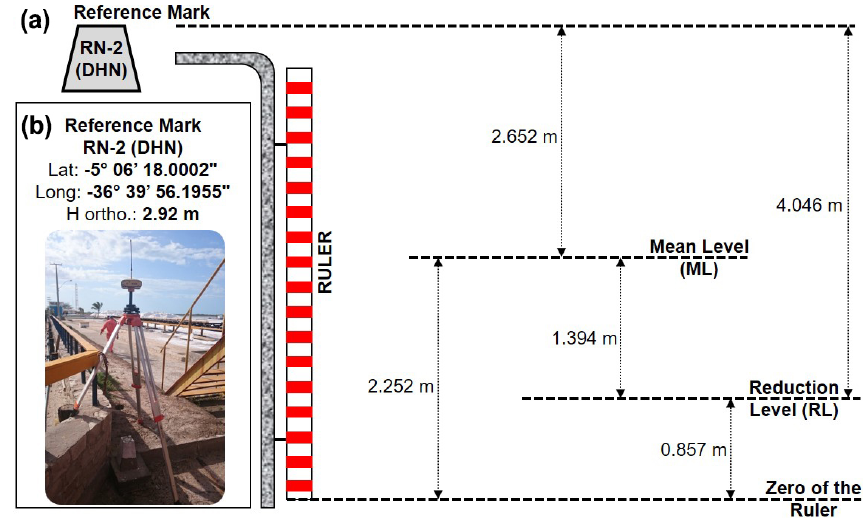
Figure 3. Scheme illustrating the differences in quotas between the references adopted by the Brazilian Navy: (a) reference mark RN-2 (DHN) and (b) coordinates of reference mark RN-2